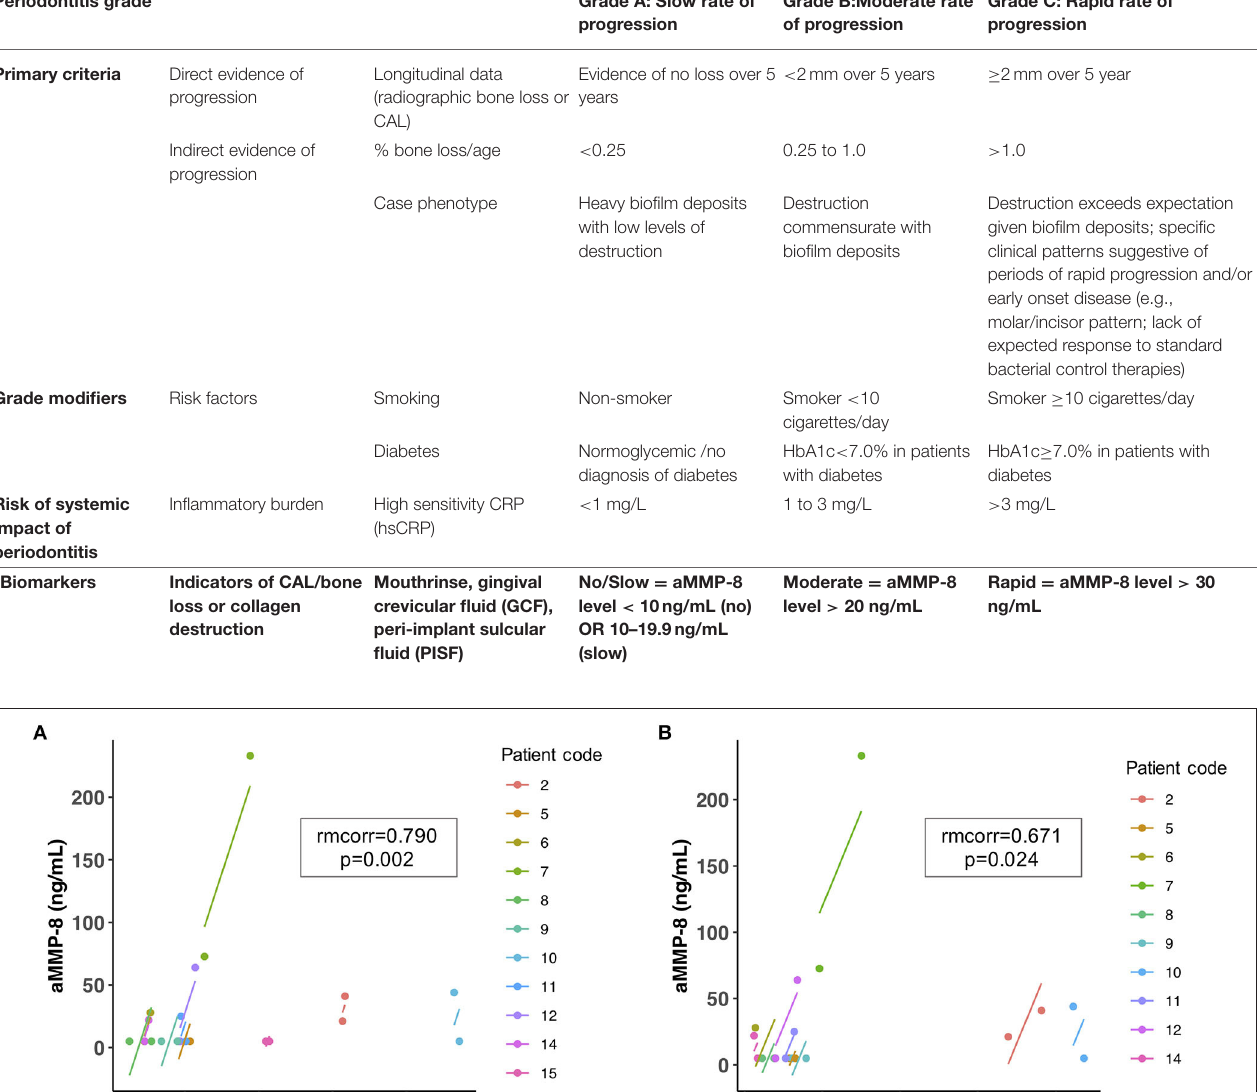
TABLE 1 | Periodontitisgrading classification with aMMP-8 implemented as the biomarker (Tonetti et al. [100] table modified by Sorsa et al. [25] * ). Periodontitis grade